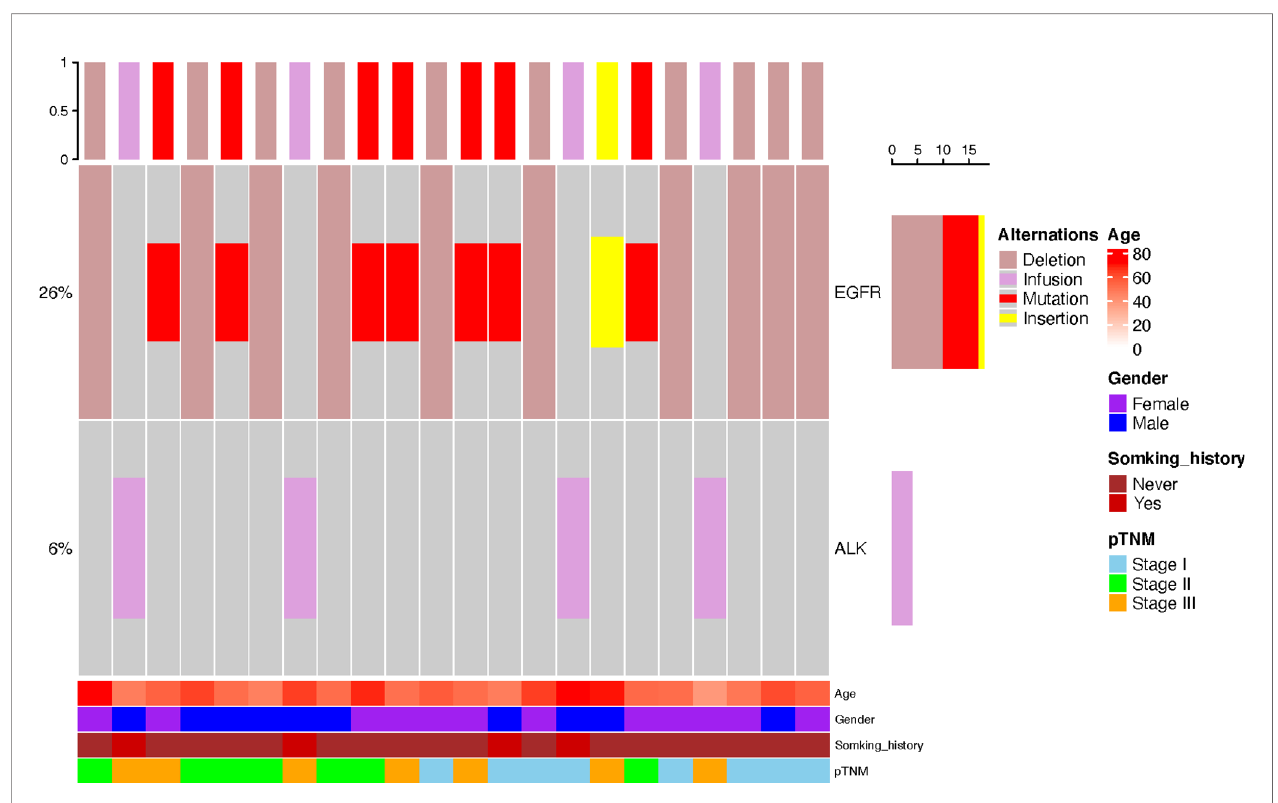
FIGURE 2 | Genetic alternations of patients with resected C-LCNEC and